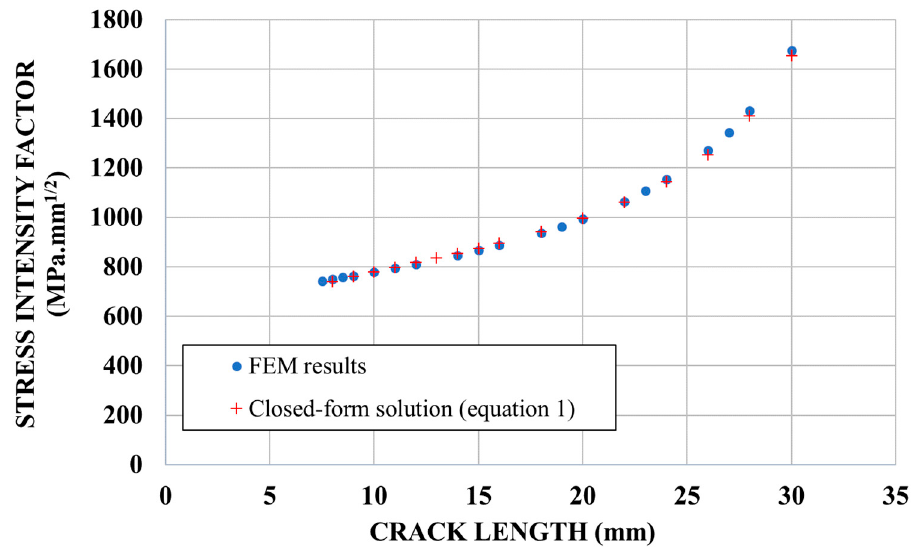
Figure 6. SIF (Stress Intensity Factor) versus crack length for un-strengthened specimens.